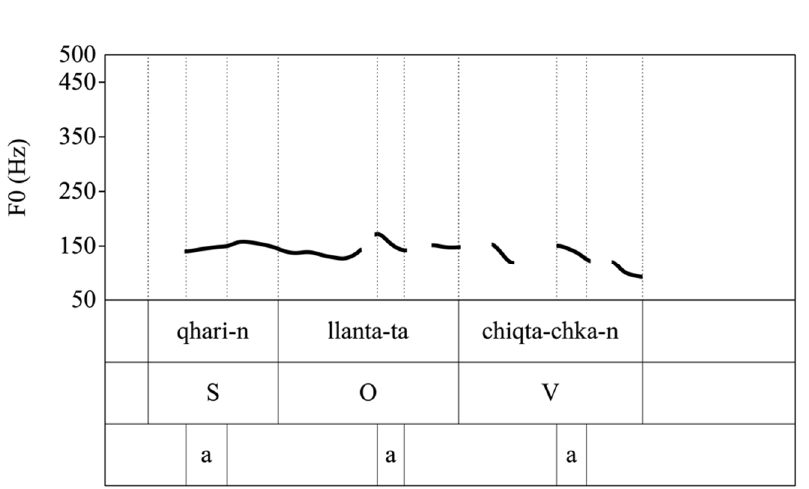
Figure 2. Intonational contour corresponding to example (15), as produced by a male speaker of Cusco Quechua.